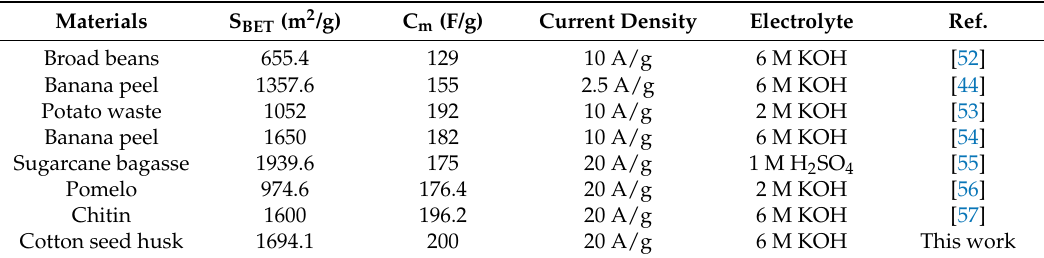
Banana peel 1650